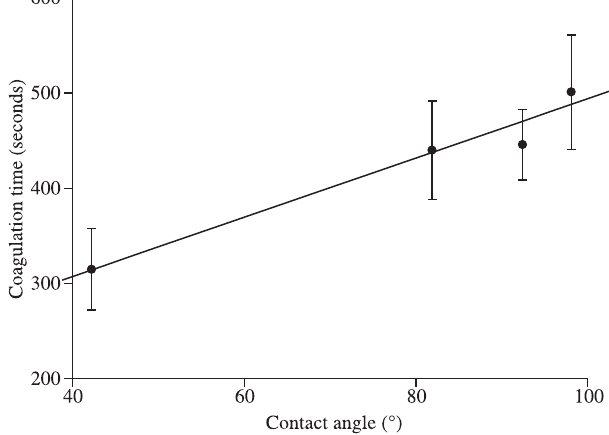
Figure 5. Coagulation time of blood in contact with glass surfaces with dif- ferent contact